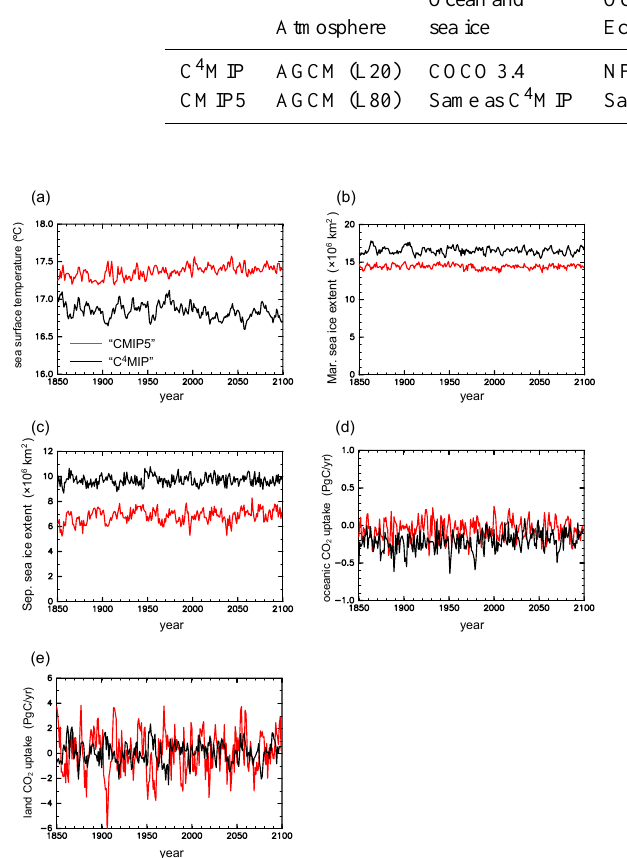
Fig. 2. Simulated global (a) sea surface temperature, (b) September and (c) March mean sea-ice extent in the Arctic Ocean for “C 4 MIP” (black) and “CMIP5” (red) in the control simulations. Global annual mean (d) oceanic and (e) land CO 2